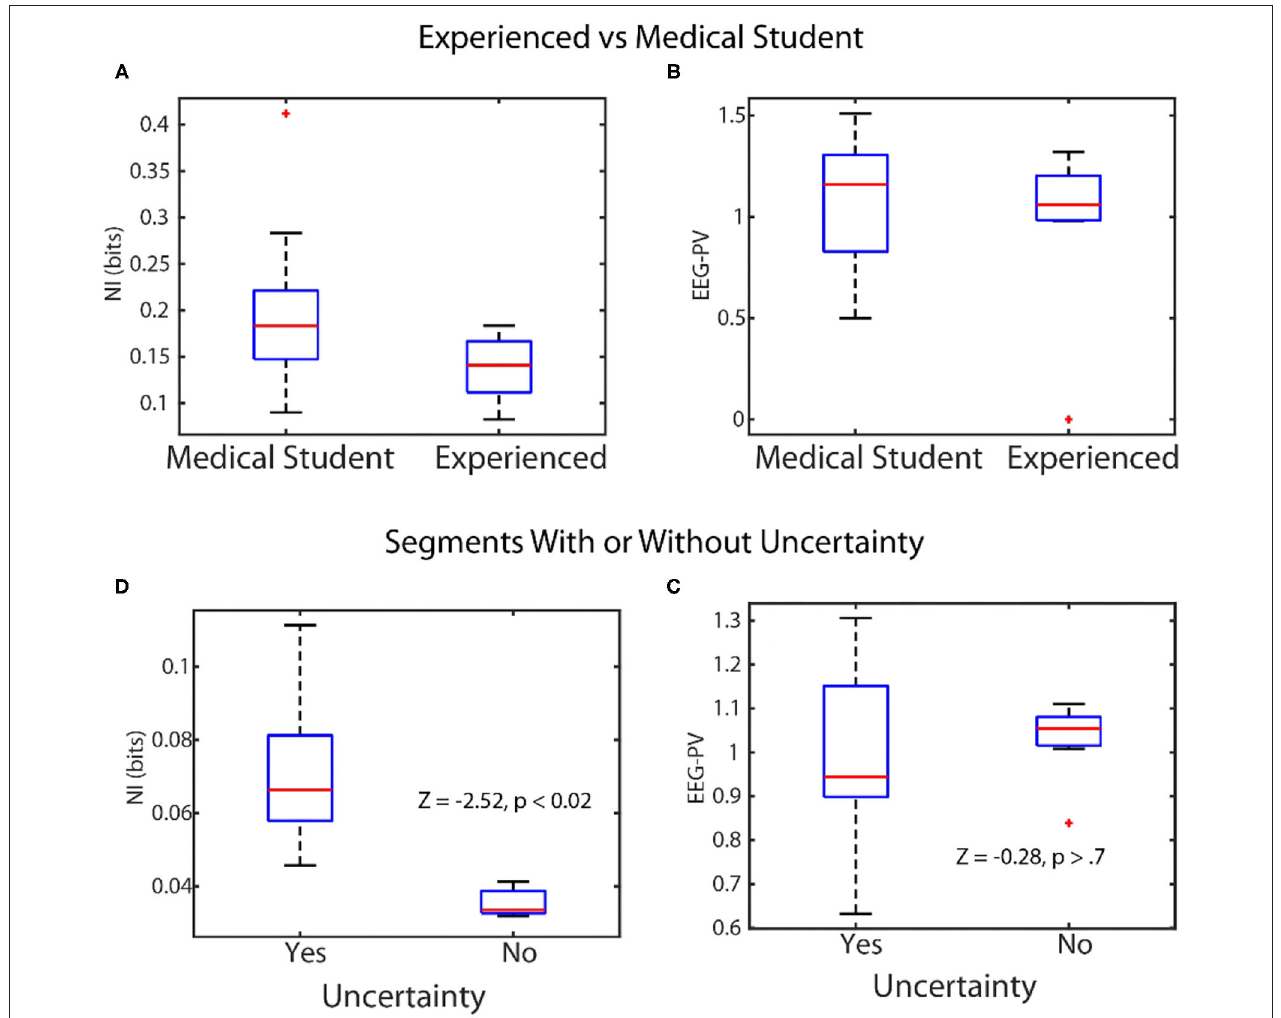
FIGURE 5 | Linking levels of NI and EEG-PV with observable behaviors. Top: The scalp-averaged levels of NI (A) , and EEG-PV (B) were compared between fourth-year medical students ( n = 15 ) and experienced operating room physicians and nurses (n = 12 ) while they performed simulations of patient ventilation. Bottom: The NI (C) and EEG-PV (D) were compared for segments from MT performances where uncertainty was ( n = 29) or was not ( n = 10) being